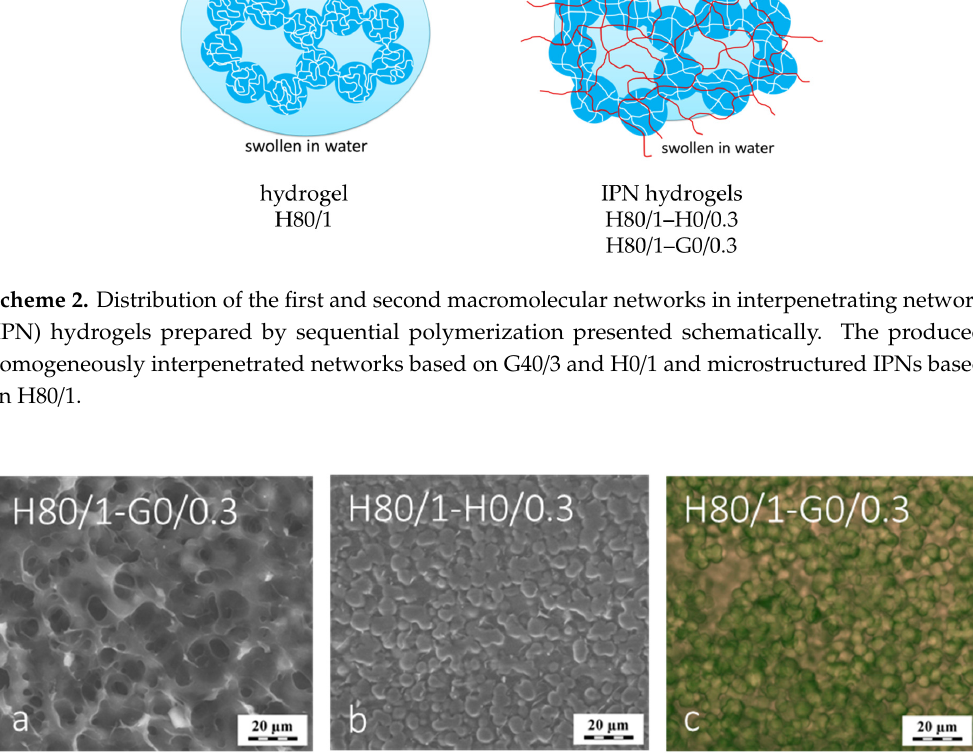
Figure 6. Cryo-SEM ( a , b ) and LSCM micrographs ( c ) of IPN hydrogels made from the macroporous first network H80/1—IPNs composition printed within images.